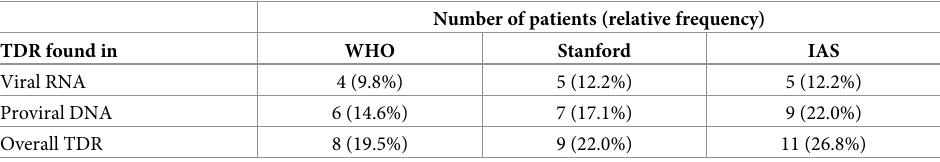
Table 3. TDR frequency according to different